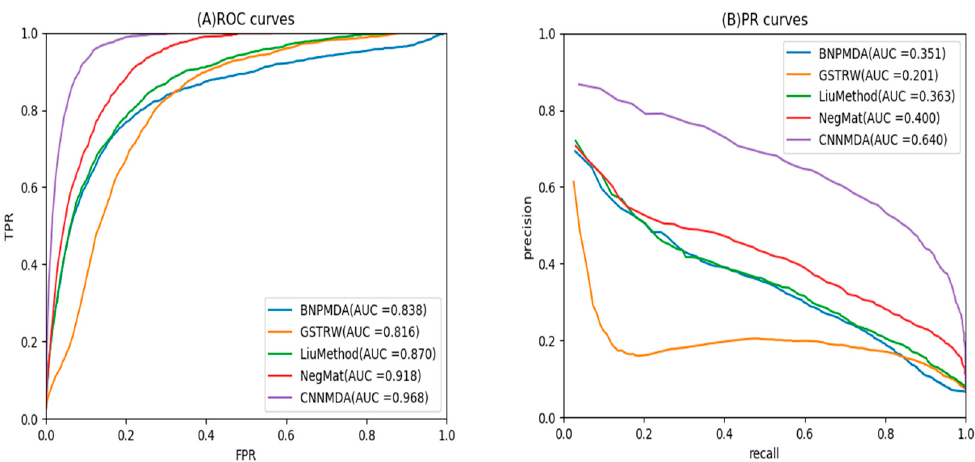
Figure 1. ROC curves and precision-recall (PR) curves of CNNMDA and other methods for 15 diseases. Table 1. Prediction results of CNNMDA and the other four methods for 15 diseases in terms of the area under the receiver operating characteristic curve (AUC).